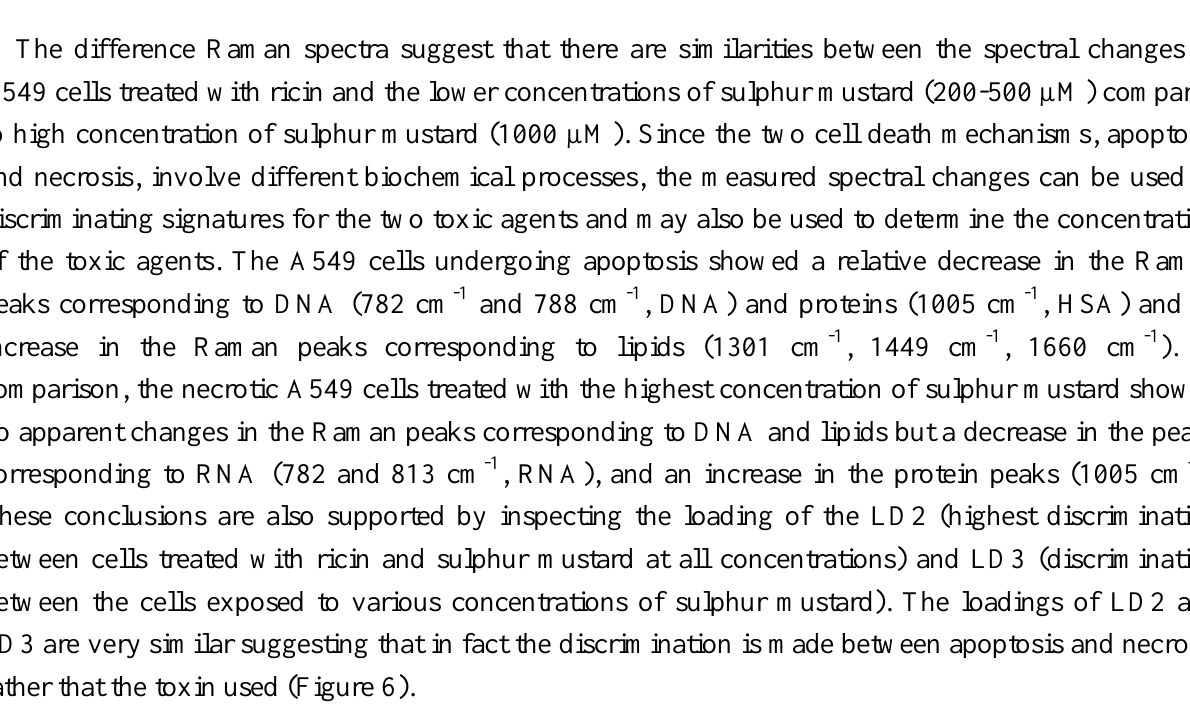
Figure 5 . Difference between the Raman spectra of healthy A549 cells and A549 cells exposed for 24 hours to ricin (Ricin 10 nM) and sulphur mustard (S.M. at 200 µ M, 500 µ M and 1000 µ